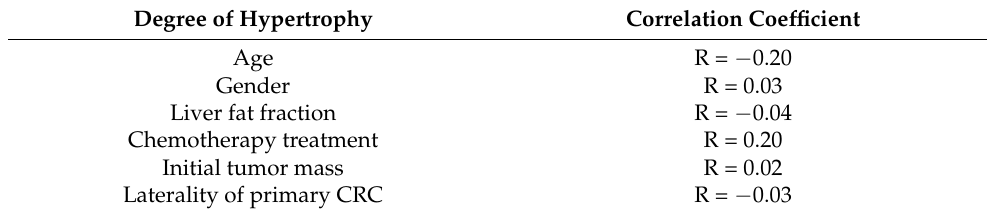
Table 4. Correlation coefficient multivariable analysis.